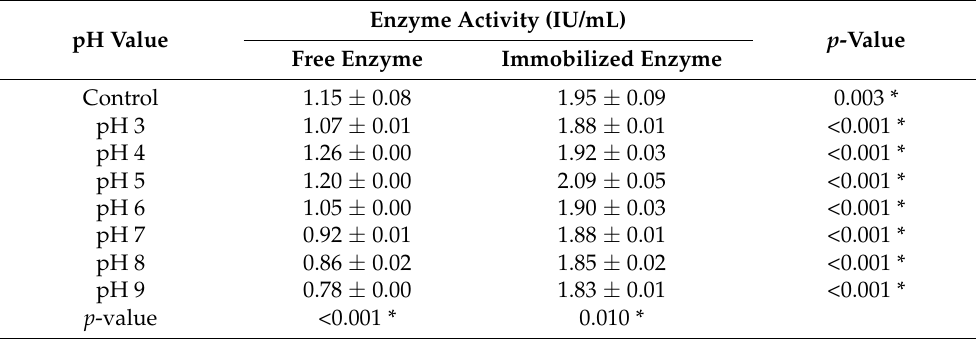
Table 2. The pH stability of free and immobilized CMCase produced by A. niger under